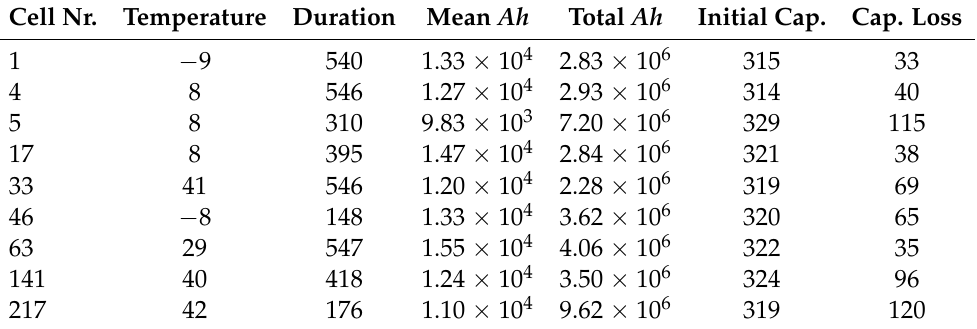
Table 3. Multiple cells’ data. An overview of the average conditions of the ageing tests. The tem- peratures are in ◦ C, the overall experimental durations are in days and the capacity fields are in mAh. Cell